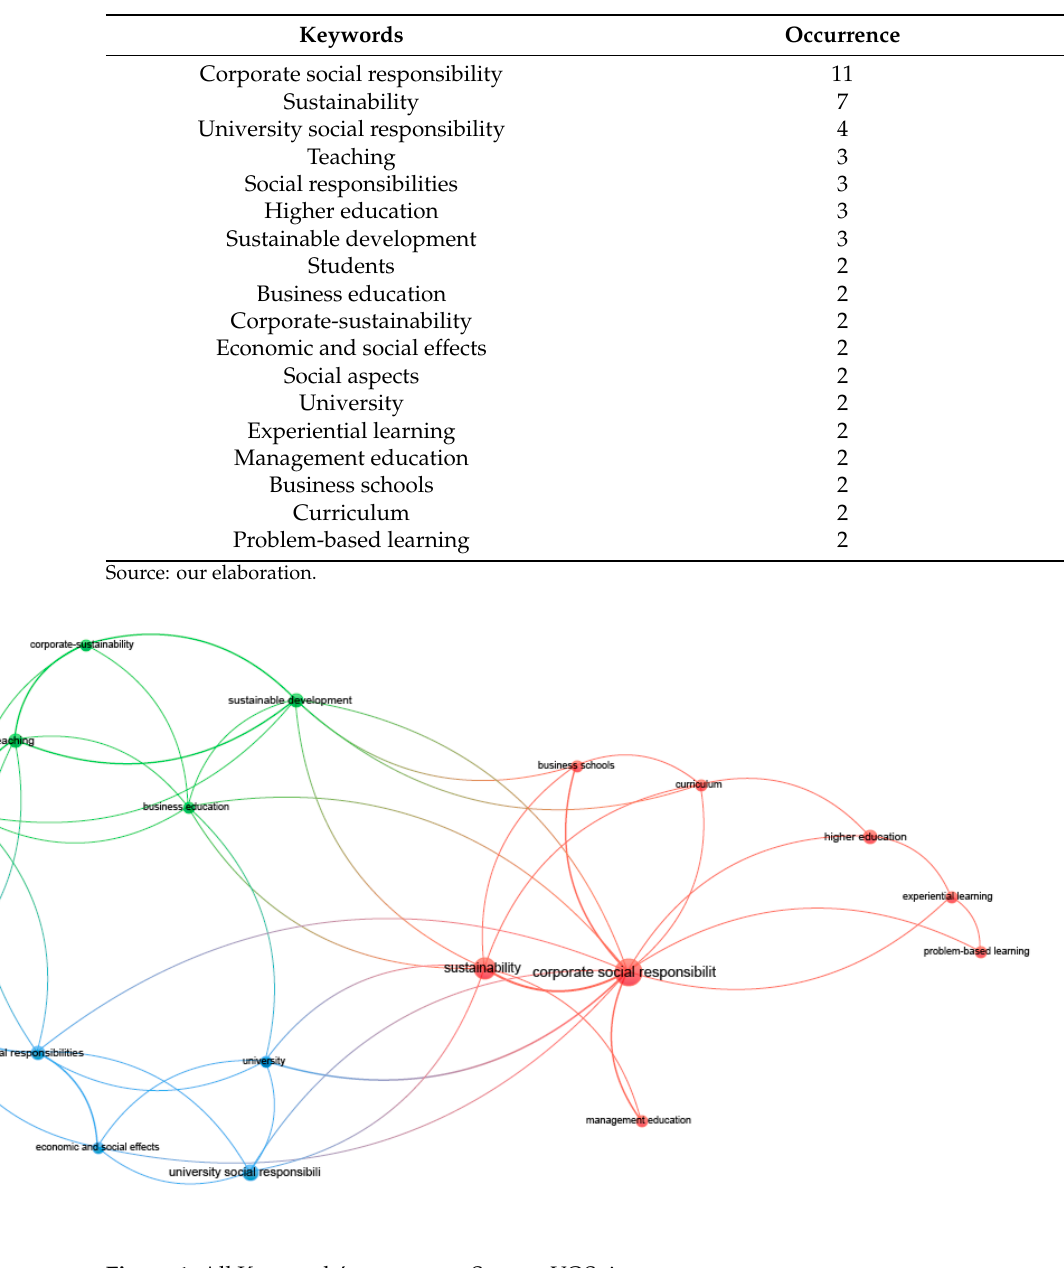
Figure 1. All Keywords’ occurrence. Source: VOSviewer.